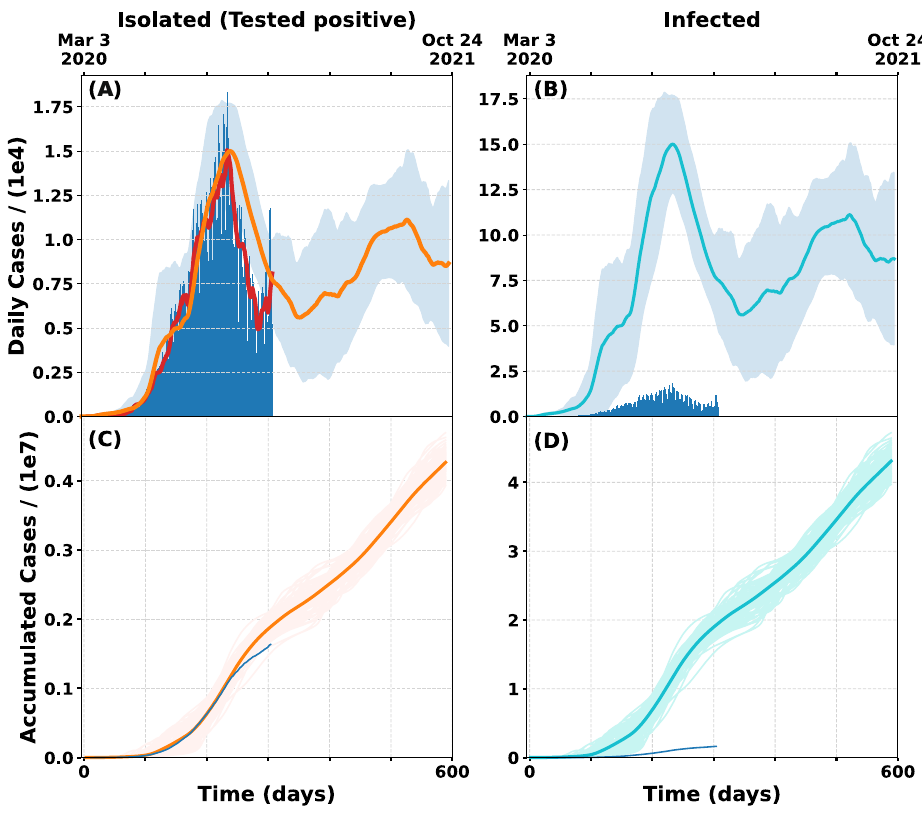
Figure 3. Geographical spread stochastic SEIQR Model fitted to Argentine data for p = 0.1 and α = 5 . ( A ) Daily isolated cases of infected people who were discovered, tested positive for COVID and isolated (orange lines) compared to official data (blue bars). The light blue shaded area corresponds to one standard deviation from the mean. ( B ) Daily infected cases in turquoise compared with official data (blue bars). Notice that infected are 10 times higher than the actual official data. ( C ) Time evolution of accumulated isolated cases obtained as the mean value (orange line) of 100 model runs. Light orange curves are the 100 individual numerical runs. The blue curve corresponds to official accumulated cases. ( D ) Time evolution of accumulated infected cases obtained as the mean value (turquoise line) of 100 model runs (lighter